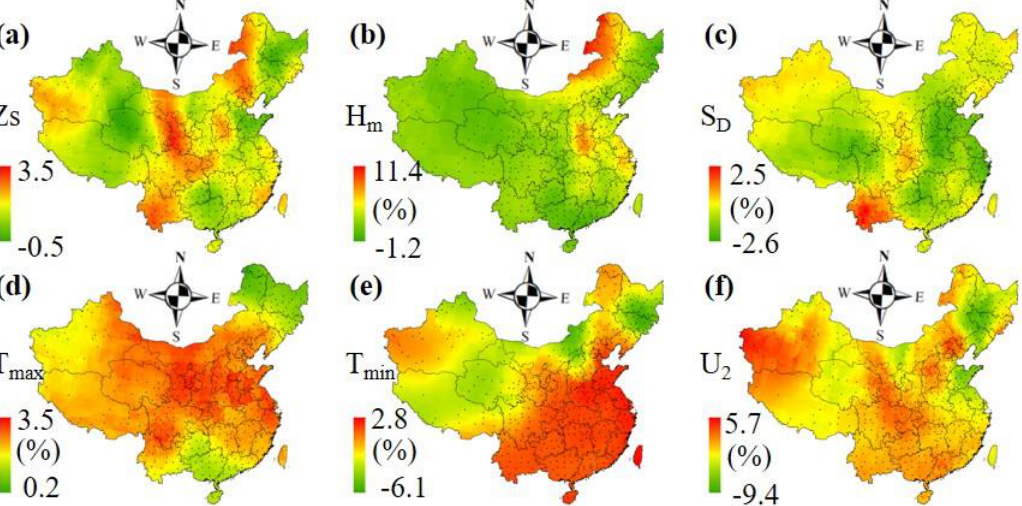
Figure 10. Spatial maps for the contribution analysis: ( a ) the M–K Zs value of ET 0 ; ( b ) the C b of RH; ( c ) the C b of S D ; ( d ) the C b of T max ; ( e ) the C b of T min ; and ( f ) the C b of U 2 .